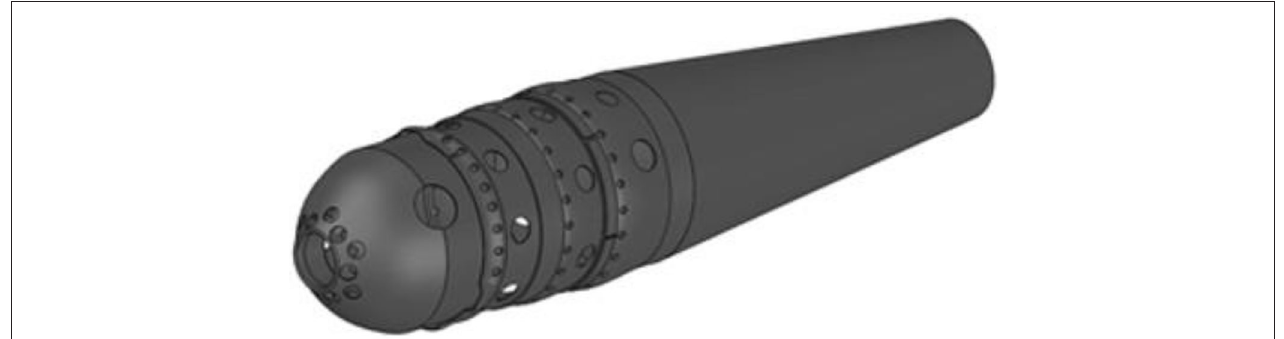
FIGURE 6 | 3D model of combustion